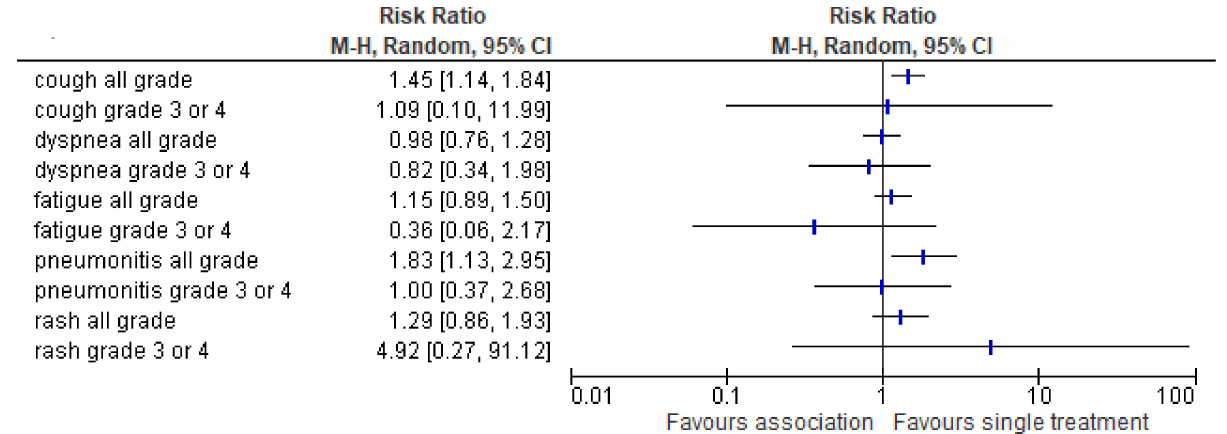
Figure 7. The risk ratio of the most frequent adverse events in the association treatment group as compared to the single Table 95. confidence interval (CI) for the adverse effect rate are shown on a logarithmic scale. Adverse events are arranged by alphabetic order (all grade AE and 3–4 grade,